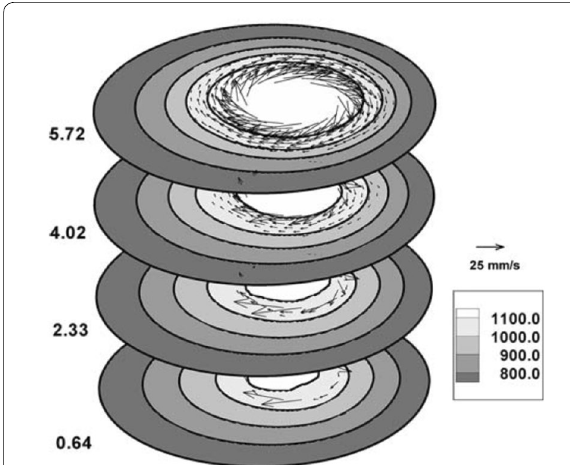
Figure 30 Plot of the temperature and the velocity for mild steel [84]